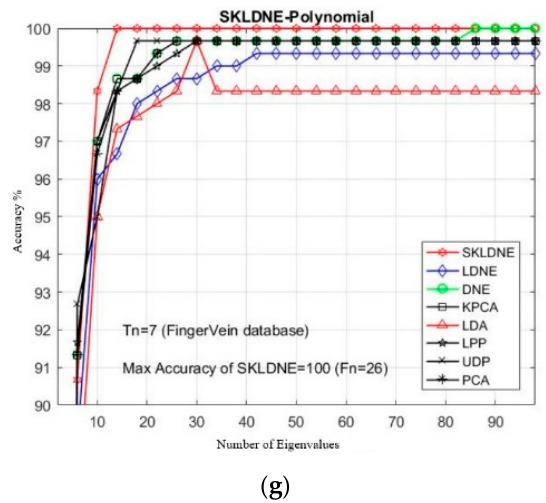
Figure 11. ( a–g ). Comparative recognition results changing the dimensionality of the transformation matrix for each given training number Tn (Finger Vein database).